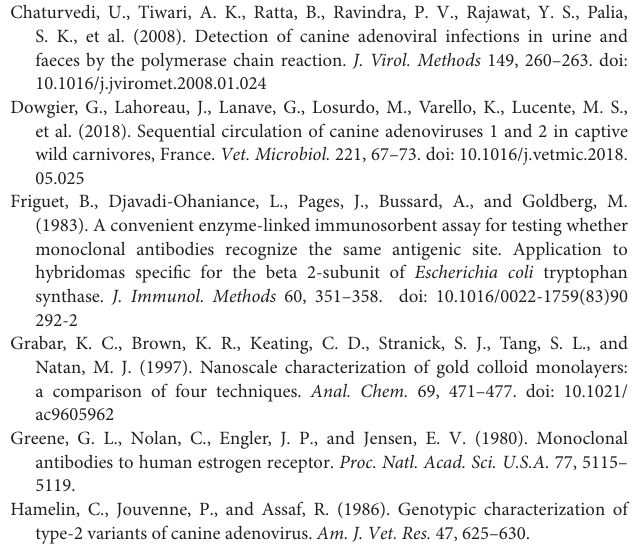
FIGURE S1 | Canine adenovirus 2 detection using mAbs via indirect immunofluorescence assay. CAdV-2-infected MDCK and CAdV-2-uninfected MDCK were fixed in paraformaldehyde prior to immunostaining with specific anti-CAdV-2 mAbs: mAb 10D1; mAb 4G1; mAb 2C1; mAb 7D7; sp2/0 supernatant; scale bars: 75 µ m. FIGURE S2 | Canine virus used for specificity testing of the ICS. The following viruses were tested using the ICS assay developed in this study: canine adenovirus 1 (CAdV-1; A ), CAdV-2 (B) , canine rabies virus (CRV; C ), canine distemper virus (CDV; D ), canine coronavirus (CCV; E ), canine parainfluenza